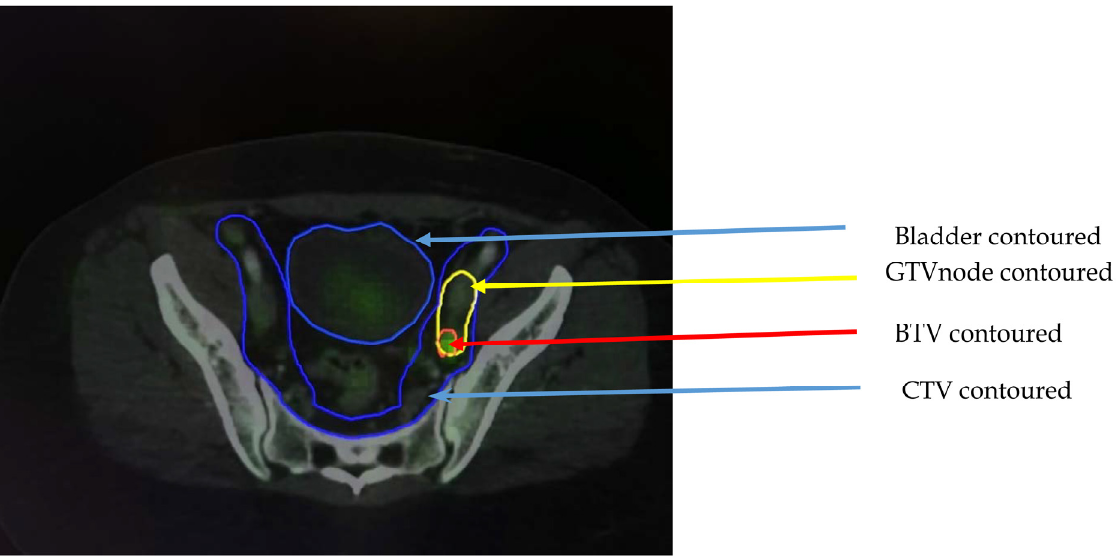
Figure 2. FIGO stage IIIC cervix cancer: Axial view of the PET/CT treatment planning with the label: Bladder (organ at risk), GTVn (Gross tumour volume-node contoured on CT), BTV (Biological tumour volume contoured on PET treatment planning) and CTV (Clinical tumour volume was contoured on CT planning).